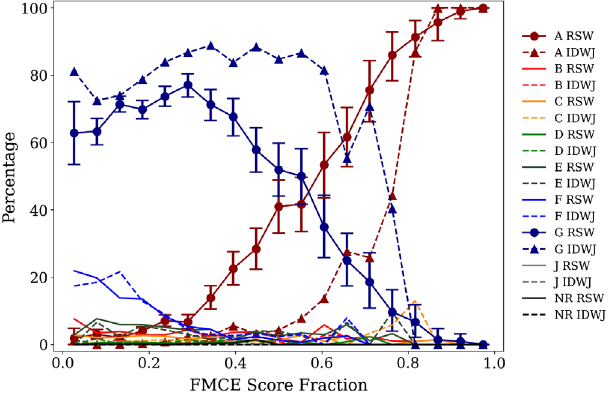
FIG. 10. Item 11 IRCs: the solid lines show the IRCs for the RSW dataset, and the dashed lines show the IRCs for the IDWJ dataset. NR ¼ no response. The error bars on A and G RSW IRCs are the 95% confidence intervals of 10 000 bootstrapped sample datasets based on RSW data described in Sec. III